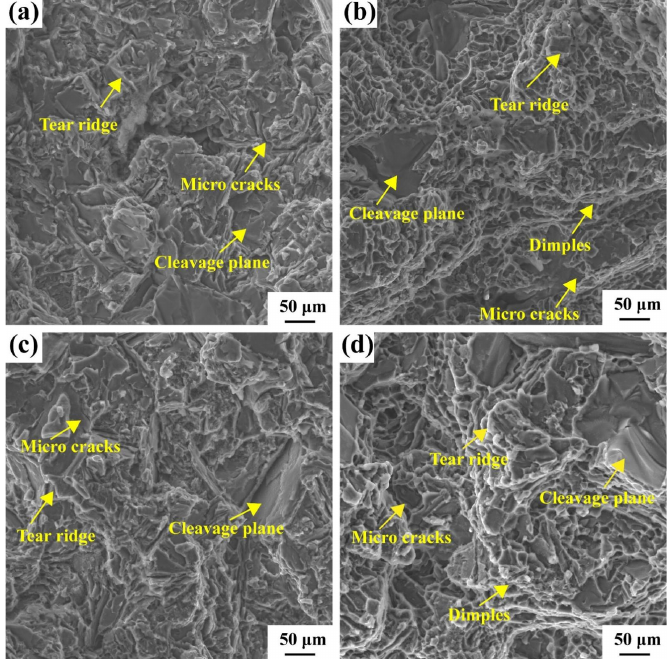
Figure 14. SEM micrographs of the typical fracture surface of the ( a ) as-cast alloy at 25 °C, ( b ) as-cast alloy at 350 °C, ( c ) T6 state alloy at 25 °C, ( d ) T6 state alloy at 350 °C. SEM micrographs of the tensile fracture surfaces of the as-cast and T6 alloys at different temperatures are shown in Figure 15. The load transfer depends on the Al matrix, eutectic Si, and intermetallic compounds. Microcracks appear at different test temperatures (indicated by red arrows). In Figure 15a,c, microcracks span the intermetallic compounds and eutectic Si phases. Furthermore, the particles cracked